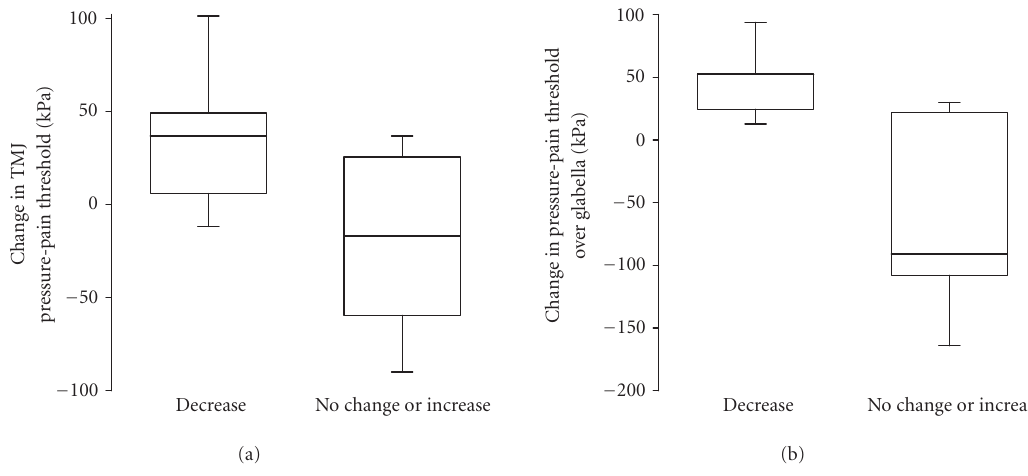
Figure 3. Relation between change in temporomandibular joint (TMJ) tenderness to lateral digital palpation and change in (a) TMJ and (b) glabella pressure-pain thresholds after intra-articular glucocorticoid treatment in patients with chronic inflammatory joint disease. (a) Ten patients had a decrease and 10 had no change or an increase of TMJ tenderness to lateral digital palpation. There was a negative correlation between change in TMJ tenderness to lateral digital palpation and change in TMJ pressure-pain threshold after treatment ( r s = − 0 . 50, n = 20, P = . 026). (b) Five patients had a decrease and 9 had no change or an increase of TMJ tenderness to lateral digital palpation. There was a negative correlation between change in TMJ tenderness to lateral digital palpation and change in glabella pressure-pain threshold after treatment ( r s = − 0 . 63, n = 14, P = .